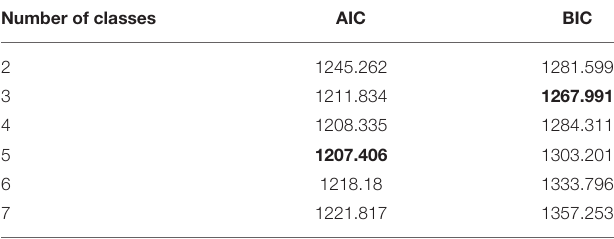
TABLE 1 | LCA goodness-of-fit statistics *